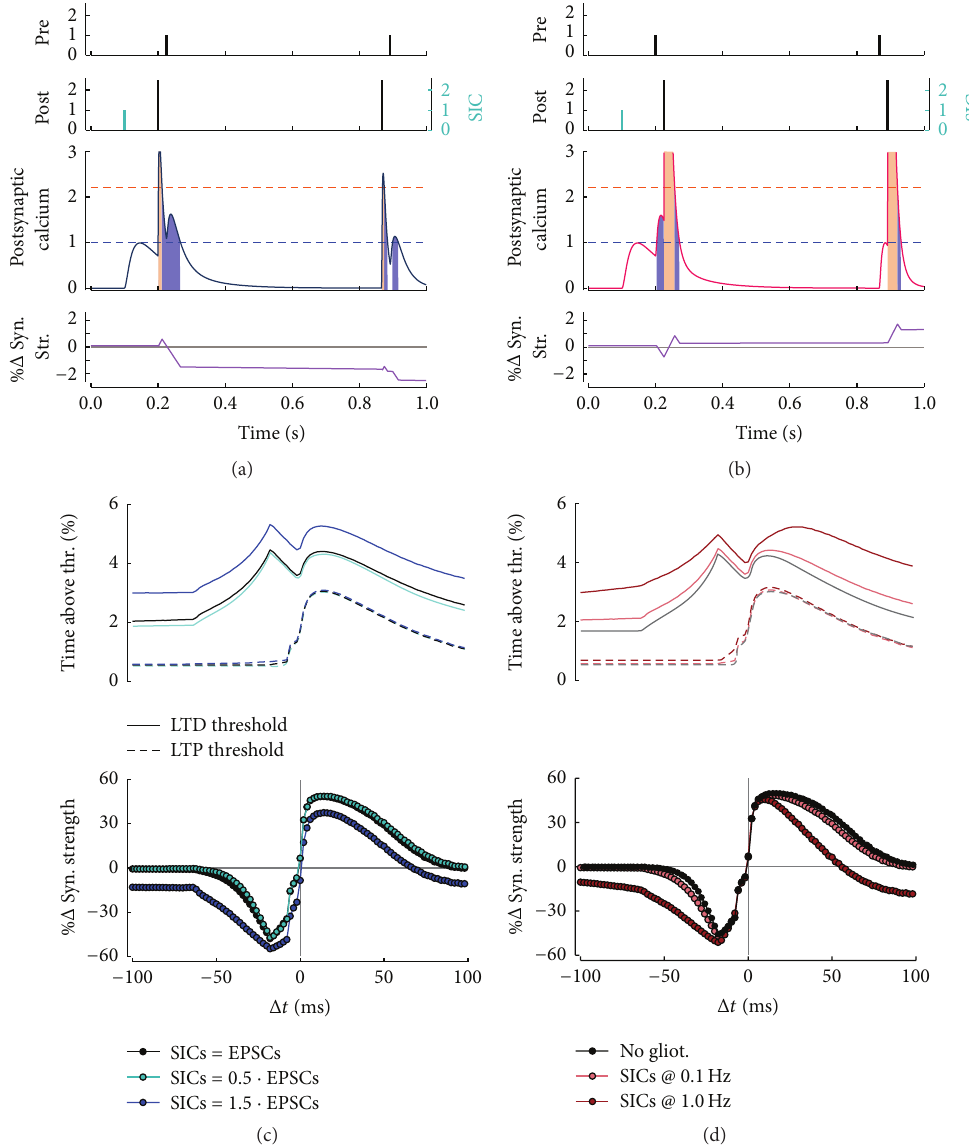
Figure 7: STDP modulation by gliotransmitter-mediated SICs. ((a), (b)) Inspection of postsynaptic Ca 2+ in the initial part of a pairing protocol that includes a gliotransmitter-mediated slow inward current (SIC) arriving to the postsynaptic neuron at 𝑡 = 0.1 s illustrates how SICs have the potential to modulate postsynaptic Ca 2+ thereby regulating LTD and LTP. (c) The magnitude of modulation depends on how large SICs are with respect to synaptic inputs (EPSCs) as well as at (d) what rate they occur. ((c), (d)) STDP curves were calculated for 60 pre/post pairings at 1Hz and included SICs starting 0.1 s before the first pairing and occurring at 0.1Hz. Synaptic parameters: 𝜏 𝑑 = 0.33 s, = 0.33 s, and 𝑈 = 0.5 s. Other parameters as in Table 1 except for 󰜚 𝜏 𝑓 0